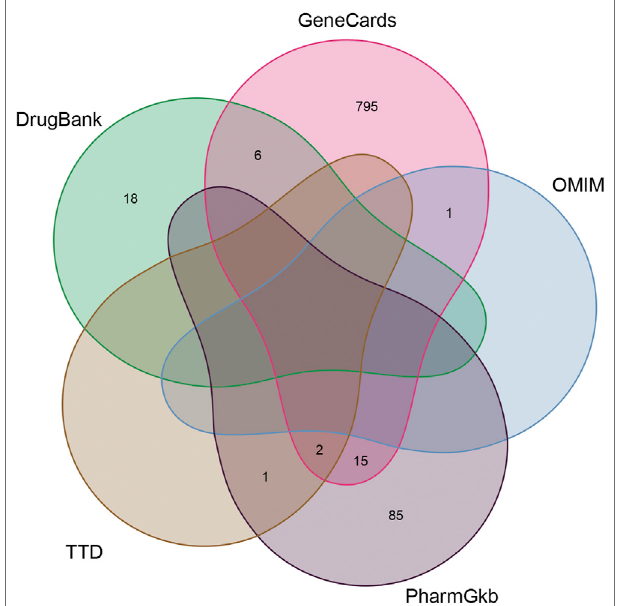
FIGURE 1 | The Venn diagram of PV targets.